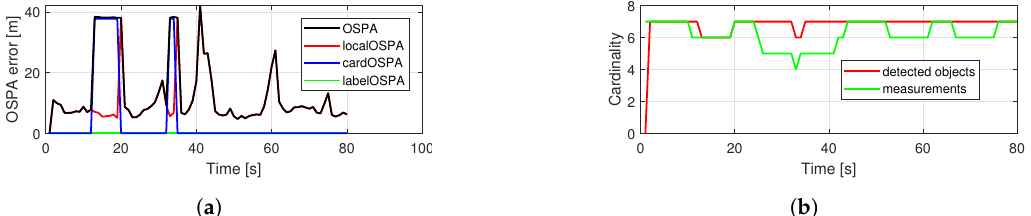
Figure 9. Performance of a single simulation with random trajectories using the proposed PHD filter. OSPA error ( a ), cardinality statistics ( b ).